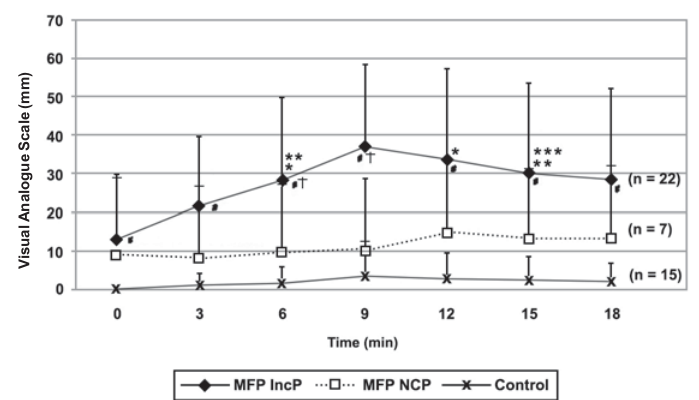
Figure 3- Pain during chewing test of patients with myofascial pain who reported a pain increase (MFP IncP), x no change in pain (MFP NCP) an control subjects